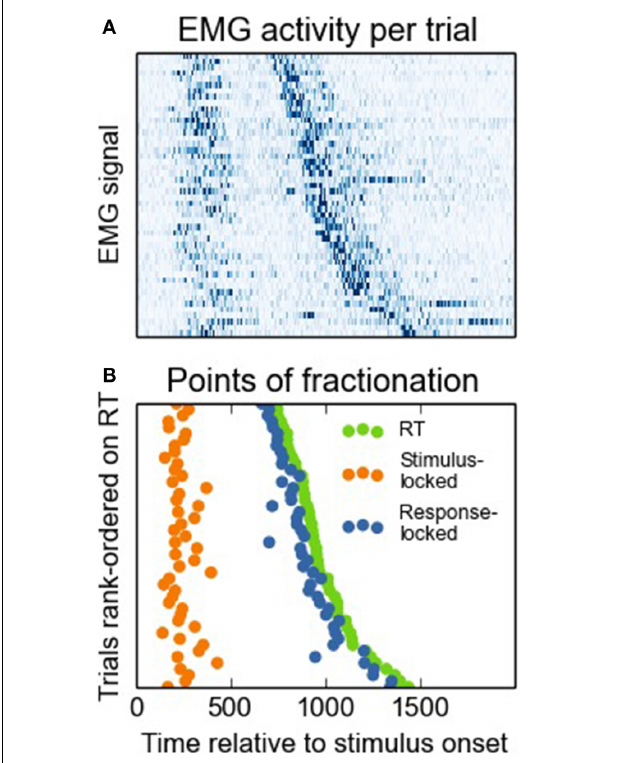
FIGURE 3 | Panel (A) depicts a heat map of normalized EMG signals per trial, rank-ordered on RTs. High amplitudes correspond to dark shadings. Panel (B) depicts how we determined EMG onsets on the basis of these signals for the stimulus-locked vs. the response-locked